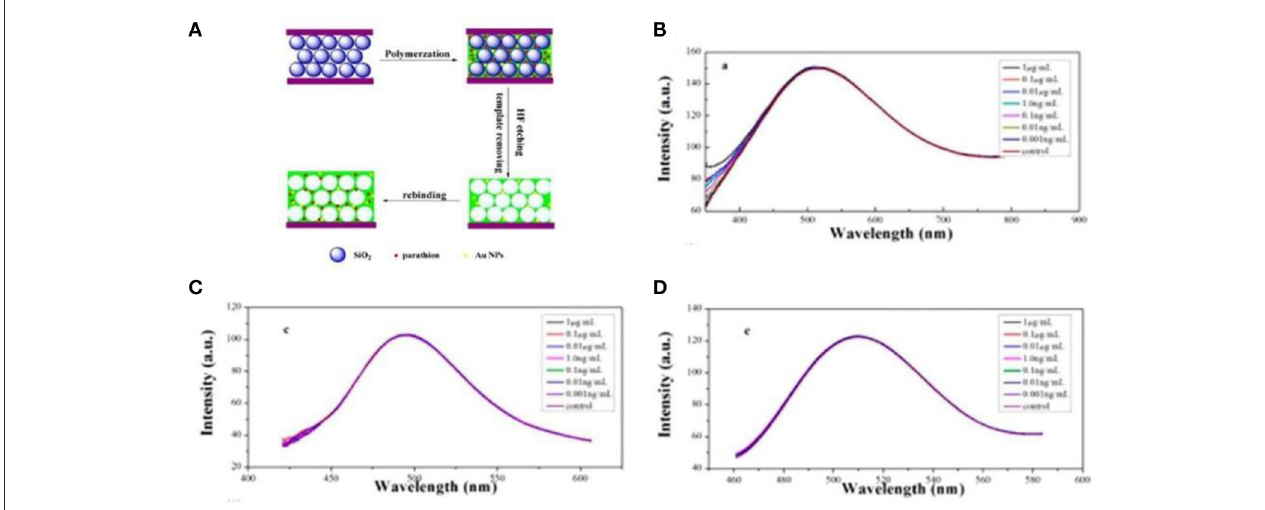
FIGURE 3 | (A) The synthetic procedure of fabricated a gold doped imprinted inverse opal photonic crystals (Au MIPs IO PCs); optical responses of Au-MIP IO PCs toward (B) methyl parathion, (C) monocrotophos, and (D) malathion (reprinted with the permission of Zhang X. et al., 2017; copyright 2017 American Chemistry